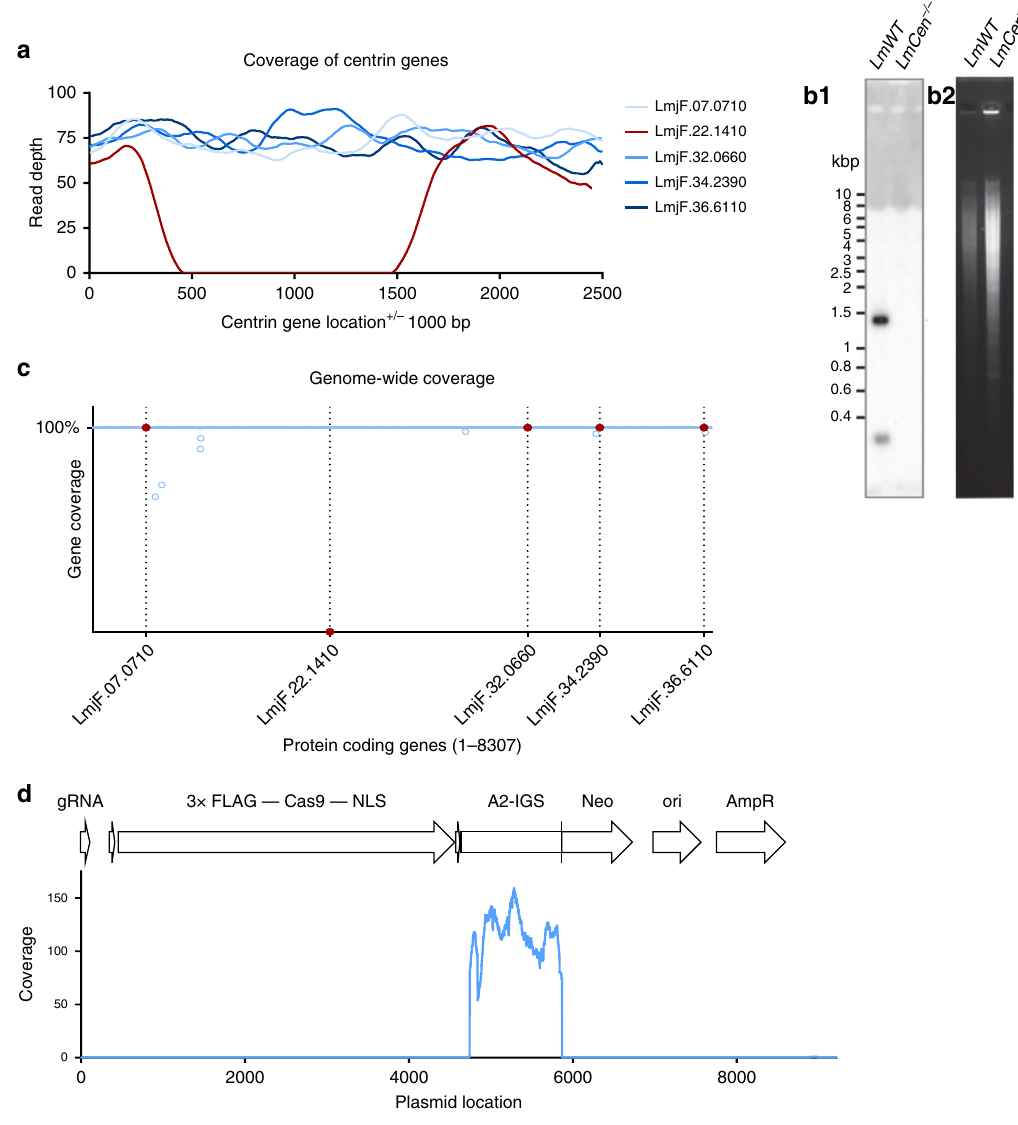
Fig. 2 Whole-genome analysis of the attenuated LmCen − / − L. major . a Sequence coverage across each of the centrin gene family members in the LmCen − / − L. major . Note that only the targeted LmjF.22.1410 centrin gene has no sequence reads resulting from CRISPR gene editing. b1-b2 Southern blot analysis ( b1 ) revealing the absence of the LmjF.22.1410 centrin gene in the genome of LmCen − / − parasite compared to wildtype L. major, LmWT . The ethidium bromide-stained agarose gel ( b2 ) showing the BglII digested genomic DNA from LmWT and LmCen − / − . c Percent sequence coverage ( Y -axis) for all protein-coding genes from chromosome 1 to 36 ( X -axis) by Illumina sequencing of the whole genome of the LmCen − / − L. major . The blue line across the X axis is composed of 8307 dots where each dot represents a gene starting from chromosome 1 (left) to chromosome 36 (right) and is placed according to the portion of the open reading frame supported by sequencing reads. Open blue circles indicate genes where misalignments of sequencing Illumina reads occurred for some multicopy genes, although these genes were veri fi ed to be intact. Red circles and line markers correspond to the 5 centrin genes across the genome in chromosomes 7, 22, 32, 34 and 36. Only the targeted centrin gene (LmjF.22.1410) has been deleted from the genome and therefore has 0% coverage. d Coverage of the pLdCN CRISPR plasmid sequence generated from whole-genome sequencing. No homologous plasmid sequences were detected in the LmCen − / − genome except for the positions ~5000 to ~6000 corresponding to the Leishmania donovani A2 gene intergenic sequence (A2-IGS) that were incorporated into the pLdCN plasmid for expression of the Neo R gene. Therefore, the A2-IGS genomic sequence reads can align to this portion of the plasmid although the pLdCN CRISPR plasmid is not present in LmCen − / − with 1 × 10 6 stationary phase LmCen − / − in one ear. Seven weeks lane 1, red arrow). Collectively, these results revealed that the centrin deleted live LmCen − / − parasites are unable to revert or post-immunization, mice were challenged with 750 metacyclic wildtype L. major (WR 2885 strain) parasites in the contralateral cause pathology and are safe for further study as a live vaccine. ear via the i.d. route (Fig. 4a for C57BL/6; Supplementary Fig. 3A LmCen − / − immunization protects against wildtype L. major . for BALB/c). Following challenge with wildtype L. major , lesion development was assessed up to 10 weeks for the C57BL/6 mice To investigate the protective ef fi cacy of LmCen − / − against wild- (Fig. 4b, c). In the non-immunized-challenged group, mice type L. major , both resistant (C57BL/6) and susceptible (BALB/c) developed a non-healing open ulcer that progressively increased mice were immunized with a single intradermal (i.d.) injection